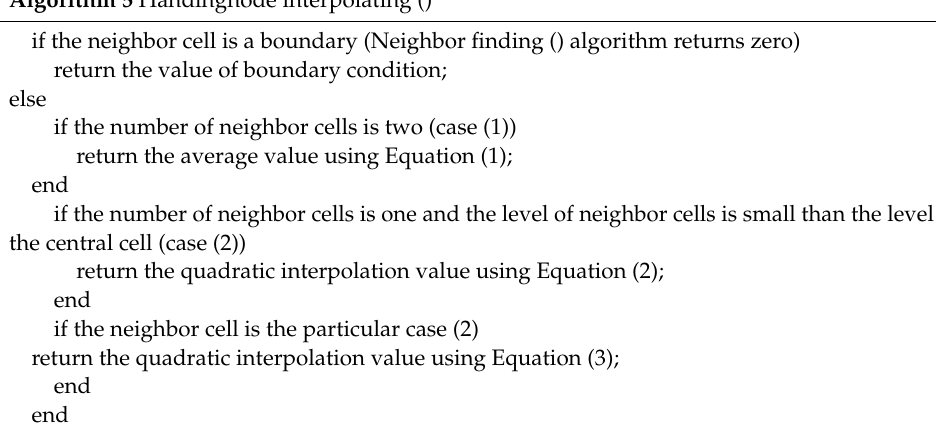
Algorithm 5 Handingnode interpolating ()